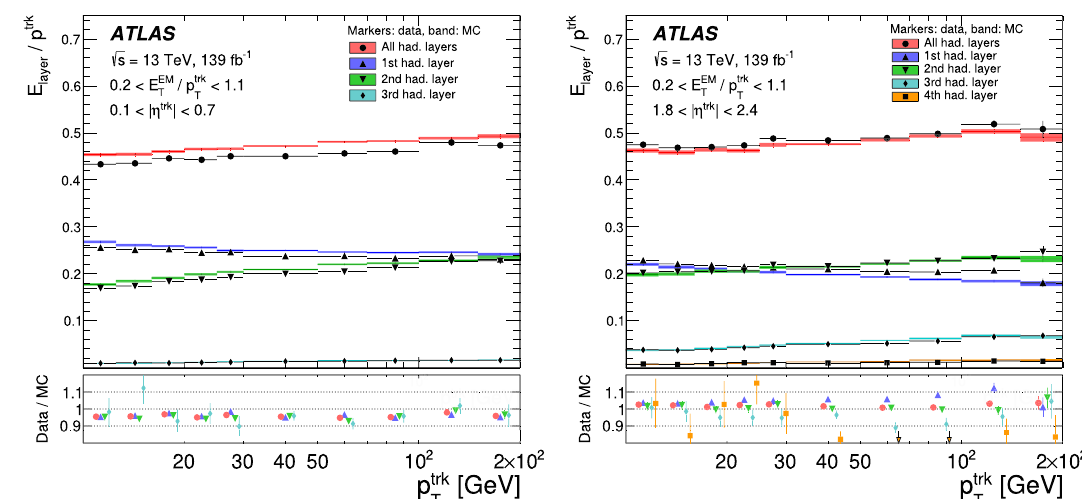
/ p trk < 1 . 1 to primarily select single-pion required to have 0 . 2 < E EM T T events. Shown in the lower panel is the ratio of data to simulation. The error bars and uncertainty band show the uncertainties from the limited number of events in the dataset and simulated samples